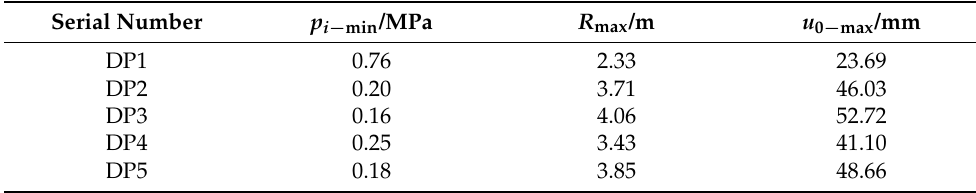
Table 3. Calculation results of different DP yield